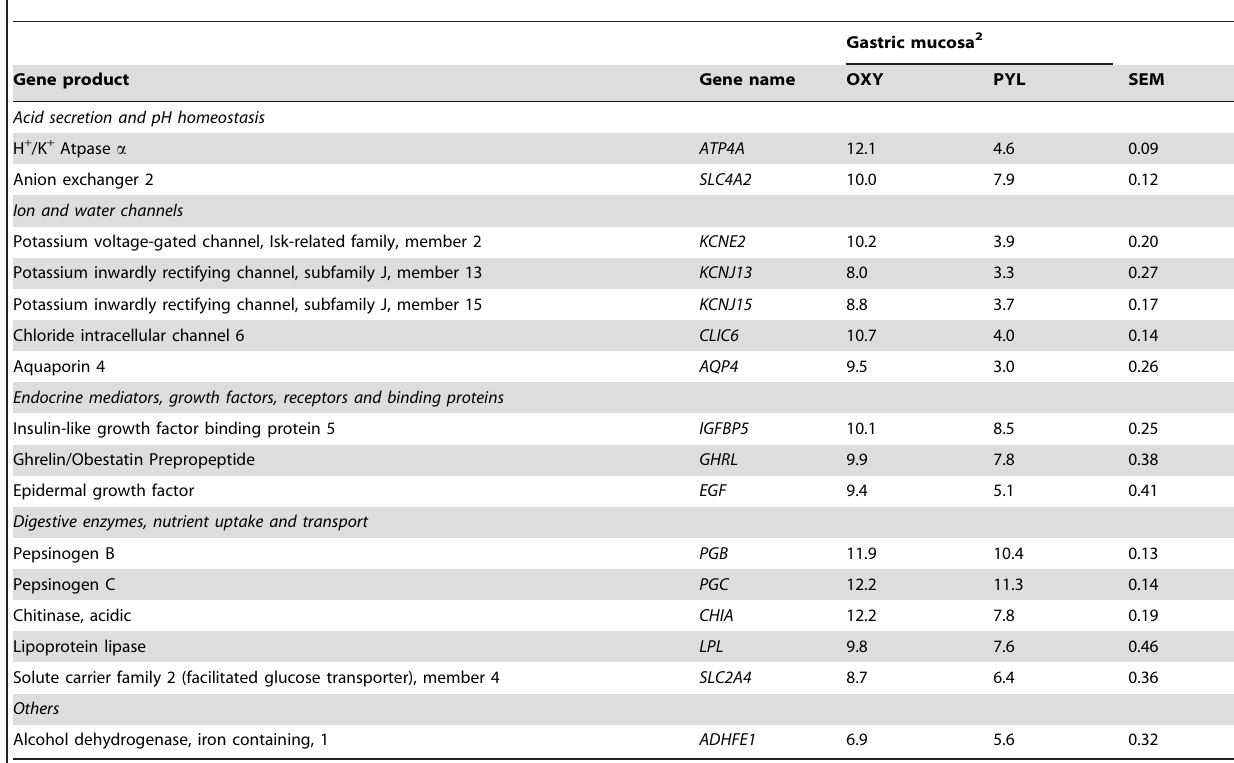
Table 3. Genes that were more expressed ( P , 0.05) in OXY mucosa, a priori selected for their relevance in the stomach, compared with PYL mucosa 1